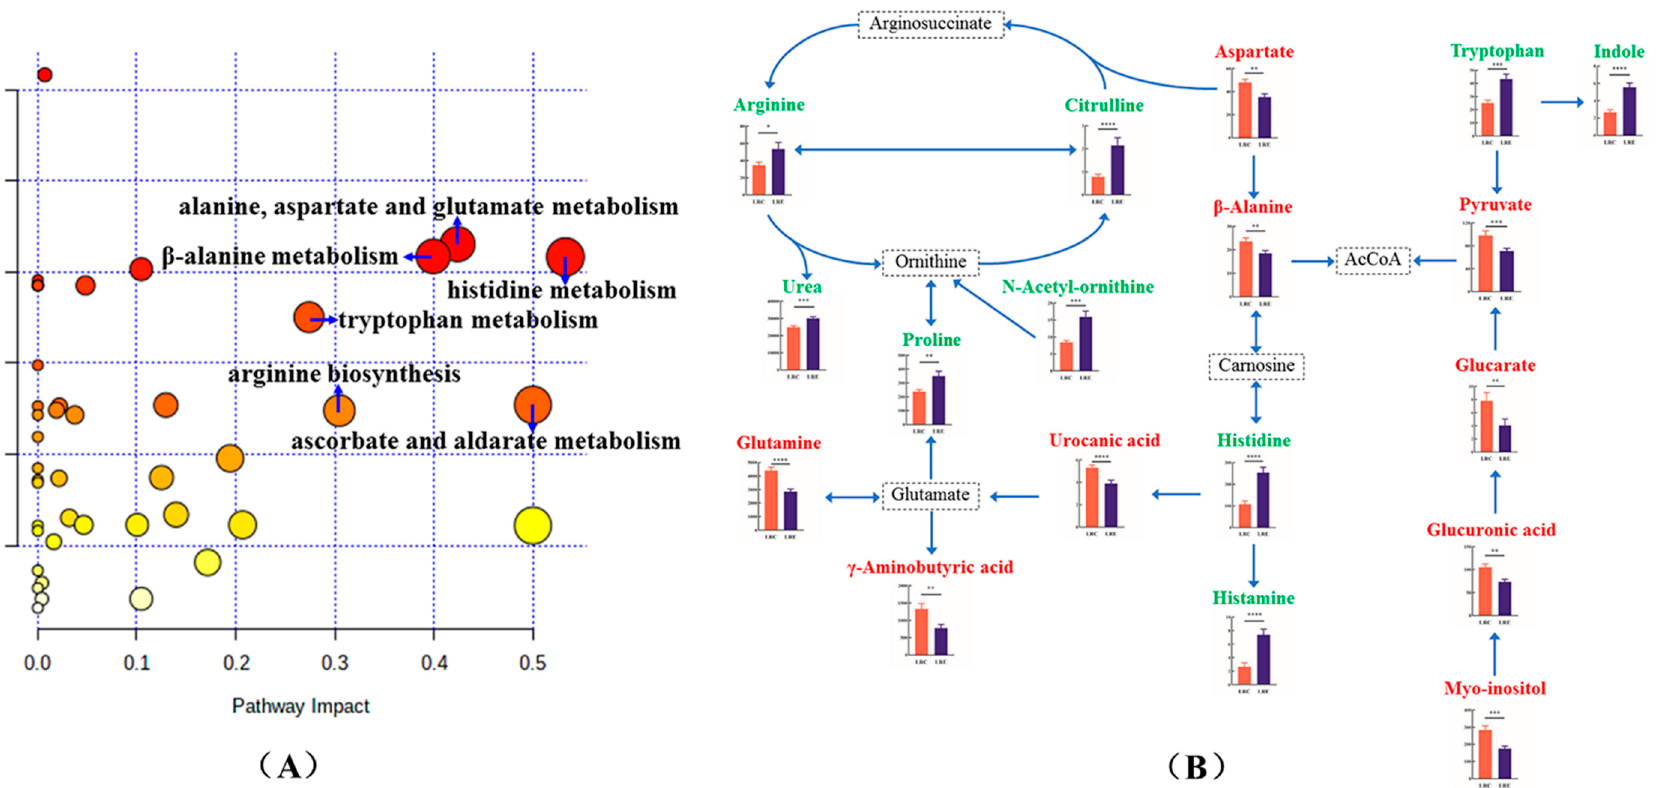
Figure 5. Metabolic pathways relevant to healthy aging. ( A ) Bubble diagram of pathway enrichment analysis ( y axis) and pathway topology analysis ( x axis) of differential metabolites. Circle size is proportional to pathway impact value, and darker red color indicates more significant differences. The names of the significantly relevant pathways in terms of impact values > 0.2 and adjusted p -values < 0.05 are highlighted, including alanine, aspartate and glutamate metabolism; β -alanine metabolism; histidine metabolism; tryptophan metabolism; ascorbate and aldarate metabolism; and arginine biosynthesis. ( B ) Schematic representation of integrative metabolic pathways, including the above 6 significantly relevant pathways. Significantly increased (red) and decreased (green) metabolites in the above significantly relevant pathways are shown. Column graphs show mean ± SEM of the differential metabolites in the LRC group (red bar) and LRE group (blue bar). * p < 0.05, ** p < 0.01, *** p < 0.001, **** p < 0.0001. Metabolites indicated in black represent that there is no significant difference between the two groups in this analysis. These significantly relevant metabolic pathways reflect a specific remodeling of amino acid metabolism in centenarians.